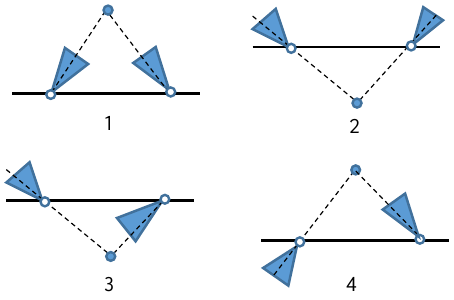
Figure 3. Four possible solutions for rotation matrix R